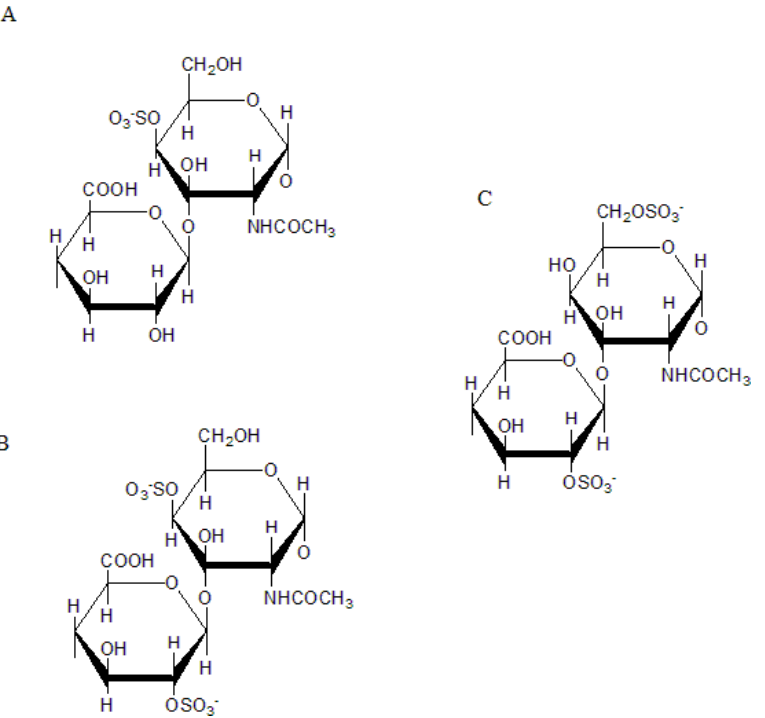
Fig. 3 – Structures of mammalian and invertebrate dermatan sulfates. A: The predominant disaccharide repeating unit of mammalian dermatan sulfate, [-4)- α -L-IdoA-(1 → 3)- β -D-GalNAc(4SO more highly sulfated disaccharide unit [-4)- α -L-IdoA(2SO makes up the heparin cofactor II binding sequence in mammalian dermatan sulfate; C: the equally highly sulfated disaccharide unit [-4)- α -L-IdoA(2SO ascidian dermatan sulfate, which does not confer any affinity for heparin cofactor II at all. The affinity of dermatan sulfate for heparin cofactor II depends not on sulfate content alone, but on the precise position of sulfate